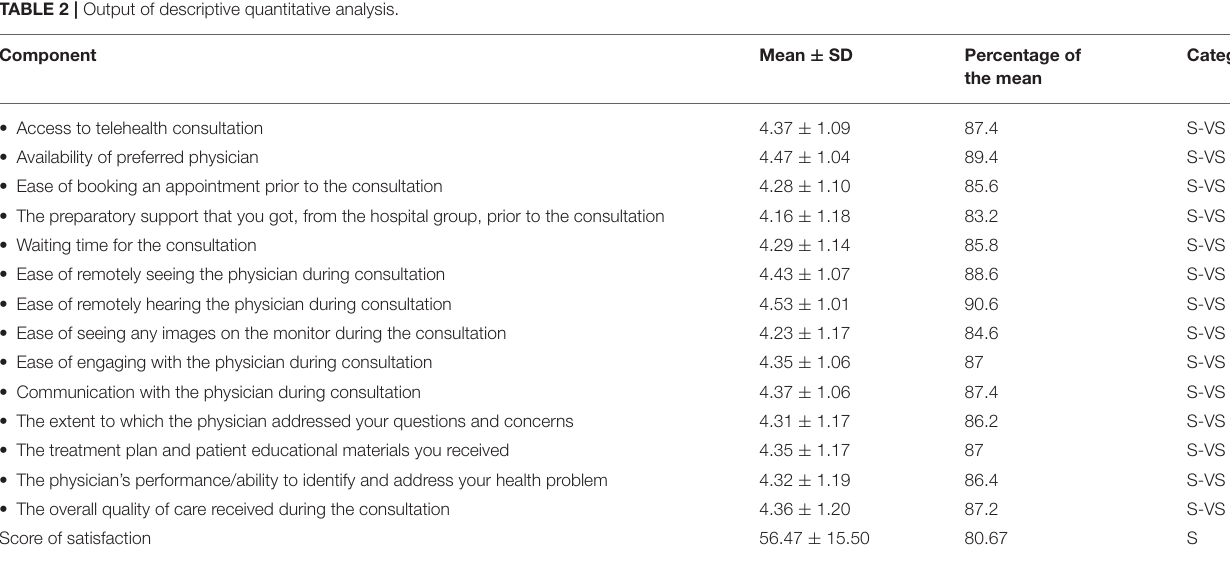
TABLE 2 | Output of descriptive quantitative